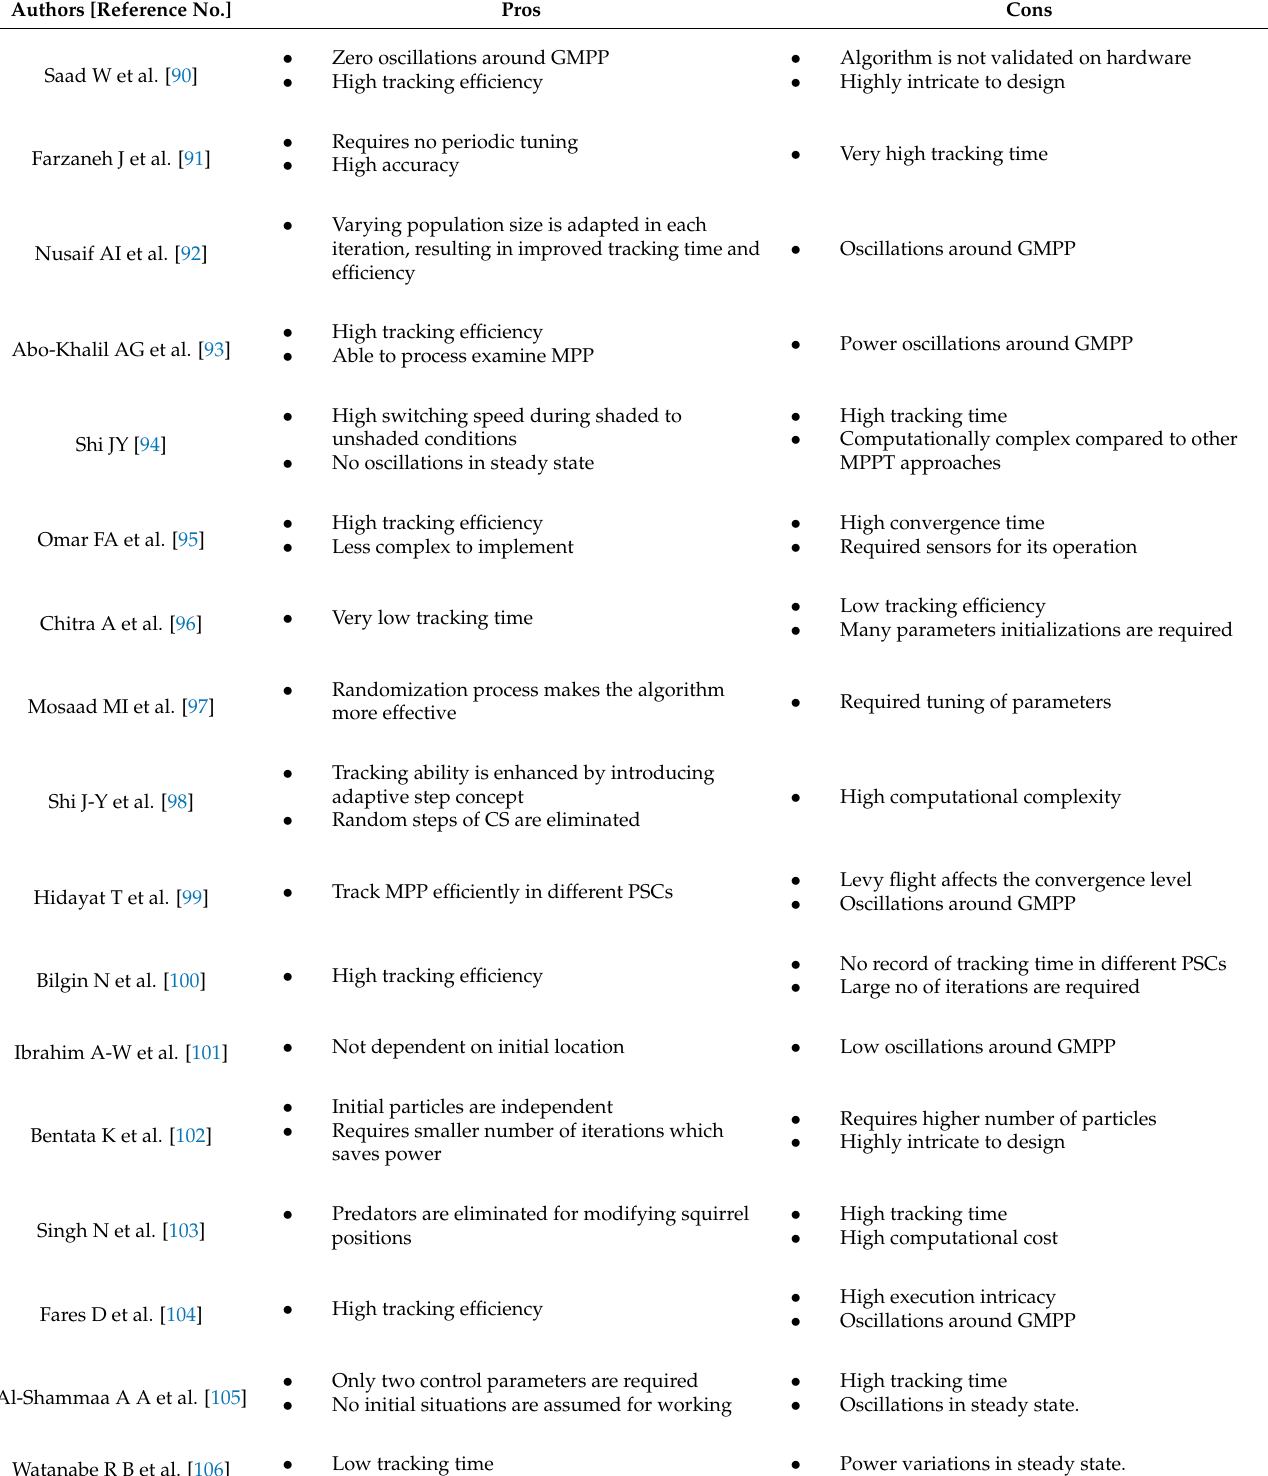
Table 6. Pros and cons of recent work based on bio-inspired